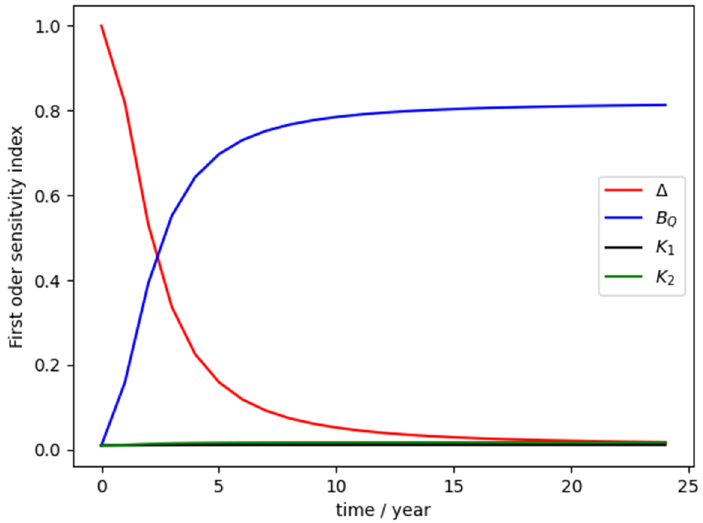
Figure 14. Sensitivity indexes for the uncertain parameters influencing the limit state equation.